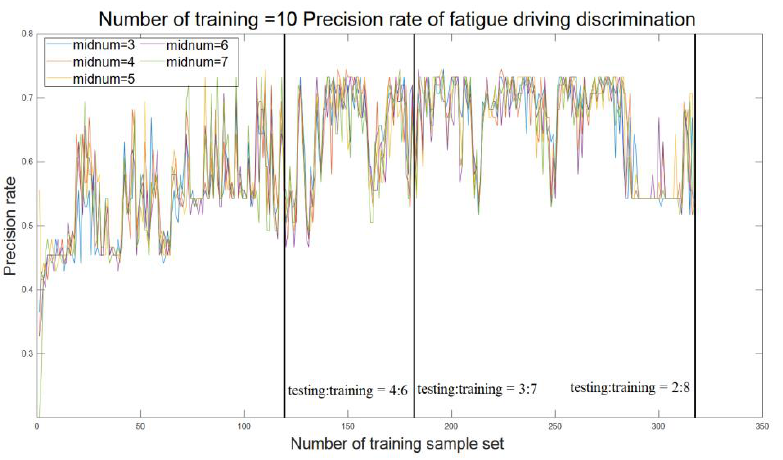
Figure 4. Accuracy of fatigue driving behavior detection varying with the number of training samples when the training times is 10.